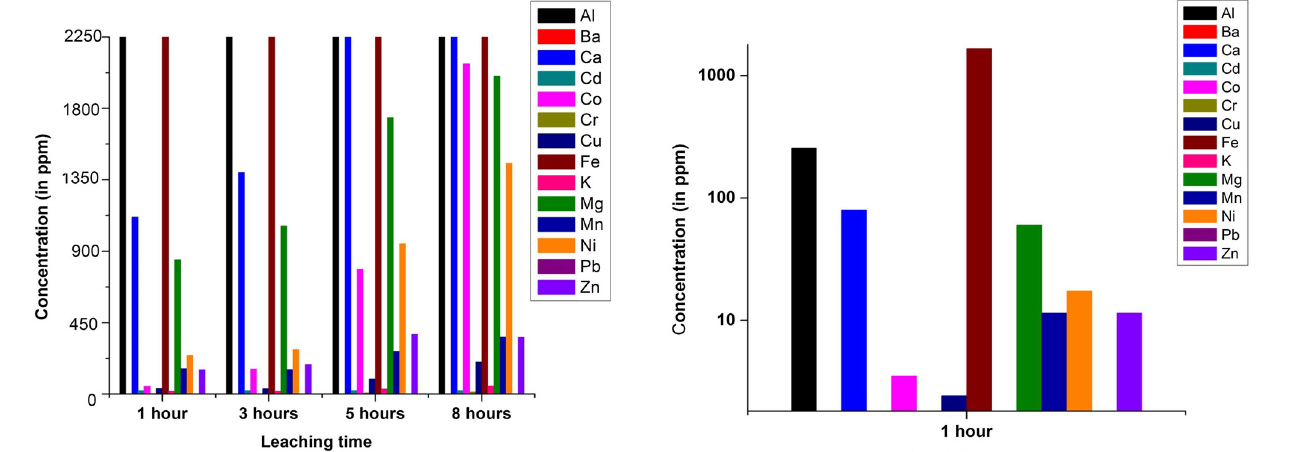
Fig. 29 Change in elemental concentration (in ppm) in aqueous leachates of Ledo coal (LC-20A) leaching for 1 h at 90 (cid:3) C